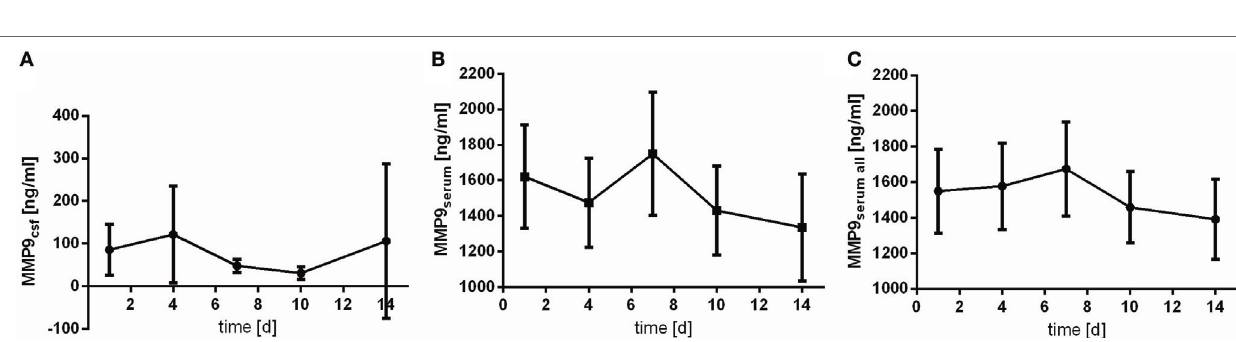
FigUre 2 | Time courses of matrix metallopeptidase 9 (MMP9) in cerebrospinal fluid (CSF) samples [ (a) ; MMP9csf], serum samples of the patients with CSF samples [ (B) ; MMP9serum], and all serum samples available [ (c) ; MMP9serum all] and their 95% confidence interval are displayed. Differences between nadir and peak values assessed via Wilcoxon Rank Test: MMP9serum: day 14 vs. day 7: p = 0.103; MMP9csf: day 10 vs. day 4: p =